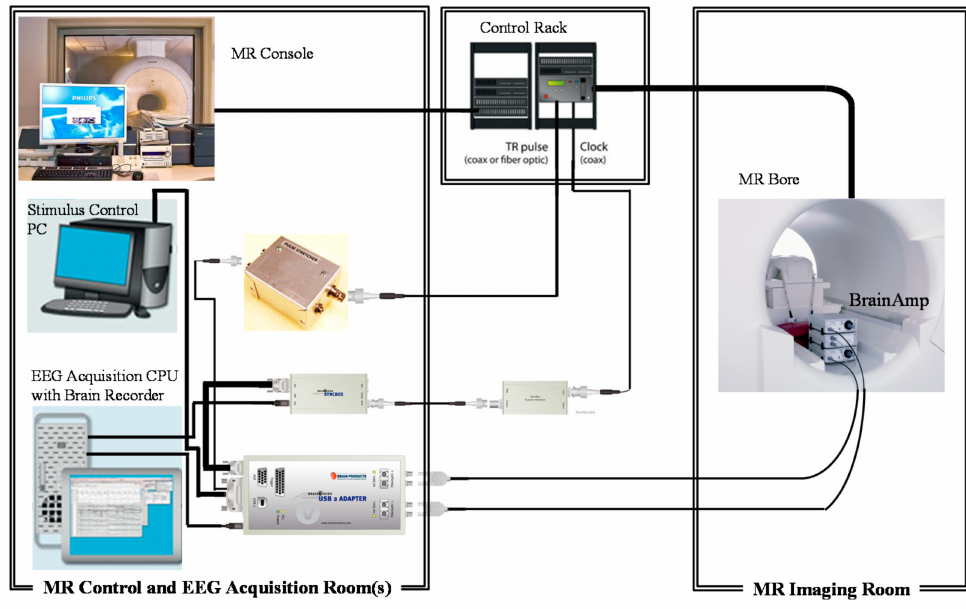
Figure 4. Schematic diagram of the experimental setup of the study.